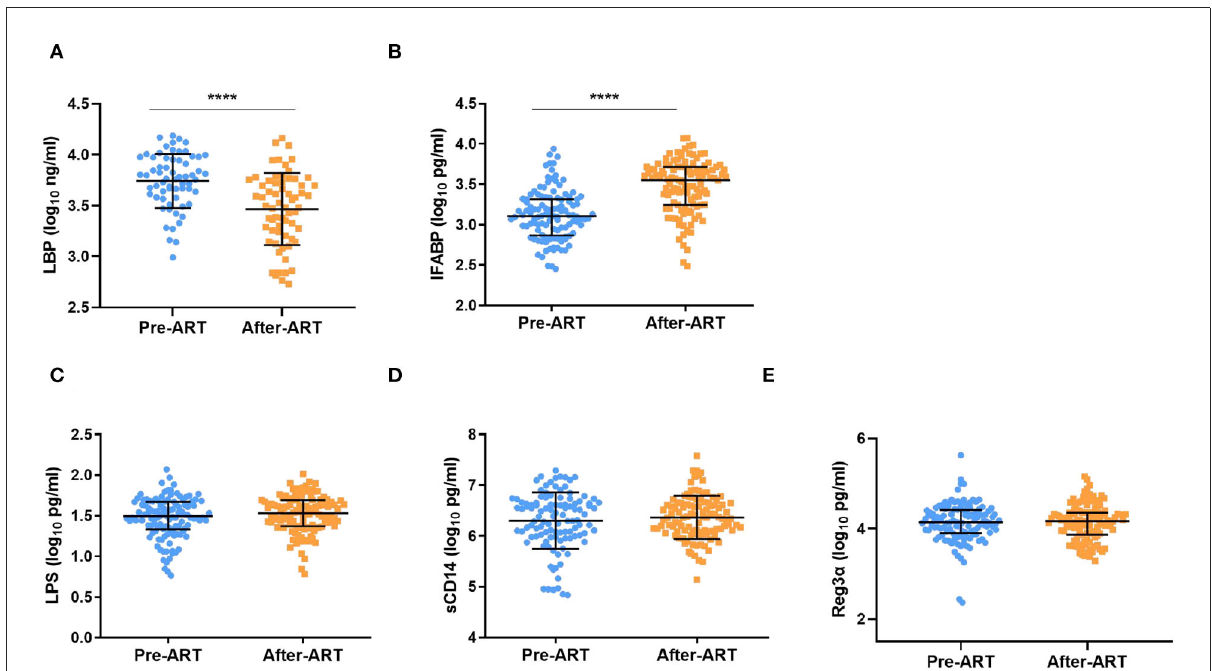
FIGURE5 Serum levels of β -D-glucan (BDG), LBP, LPS, sCD14, and Reg3 α in PLWH Pre-ART and after-ART. (A) β DG concentrations decreased slightly after ART ( n = 65, paired t test). (B) The level of LBP decreased significantly after ART ( n = 117, paired Kruskal–Wallis test);. (C–E) the plasma level of LPS ( n = 119), sCD14 ( n = 110), and Reg3 α ( n = 120) remain unchanged from pre ART to after ART ( C–E : paired Kruskal–Wallis test). **** p <